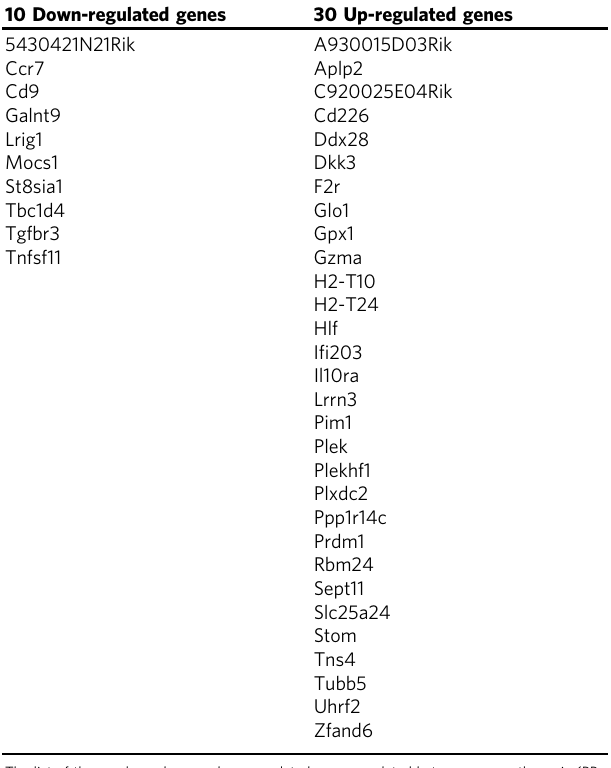
The list of the overlapped genes down-regulated or up-regulated between non-pathogenic (PP eYFP + CD4 + ) Th17 cells and pathogenic (eYFP + CD4 + ) Th17 cells from the in fl amed spinal cord of Th17 Satb1 KO mice after EAE induction. eYFP + Th17 cells were sorted at the peak of the disease (14 days after EAE